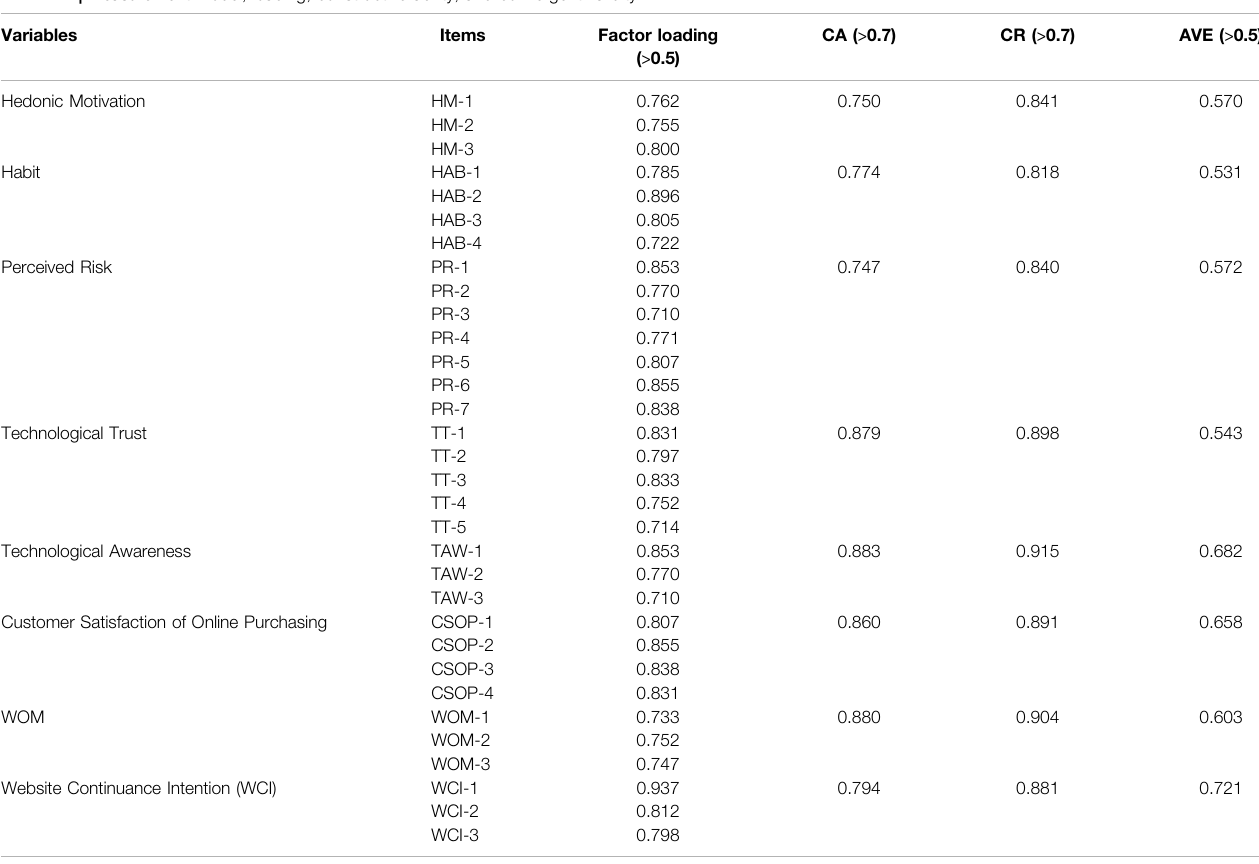
TABLE 2 | Measurement model, loading, construct reliability, and convergent validity.